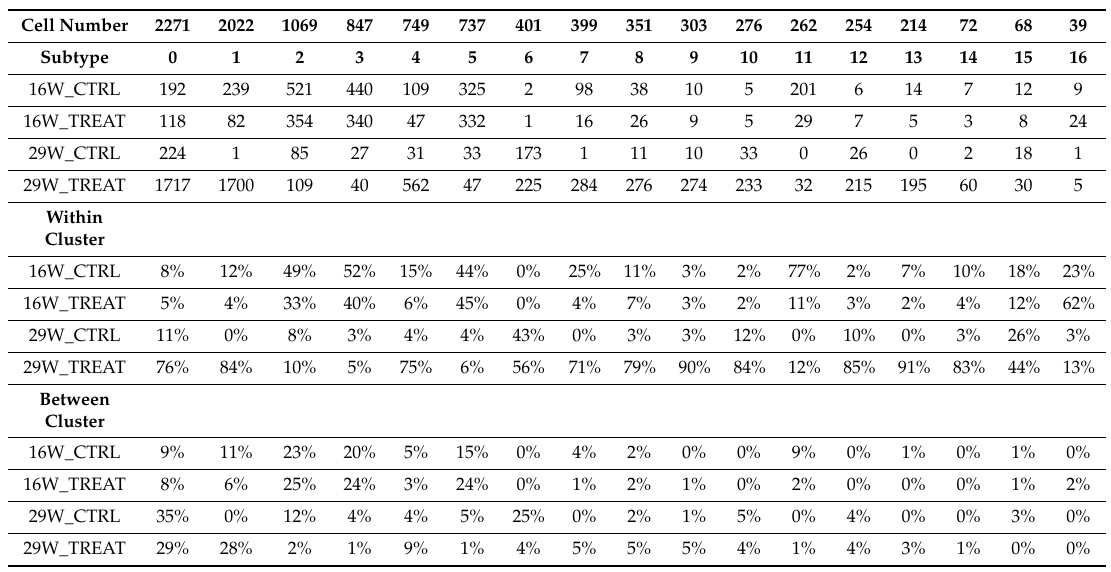
Table 2. Cell number of each of the 17 cell subtypes and their proportion in relation to the total cell composition in the four groups (16- and 29-week control and experimental